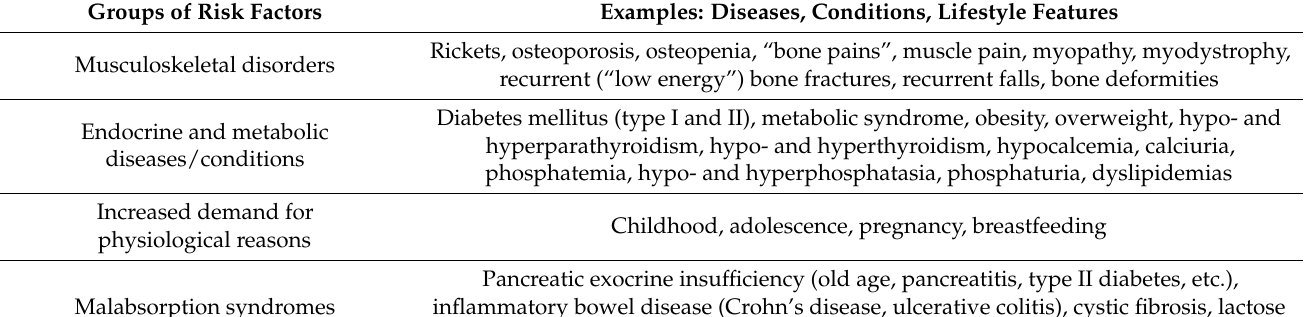
Table 1. Risk factors for low Vit. D status. Examples: Diseases, Conditions, Lifestyle